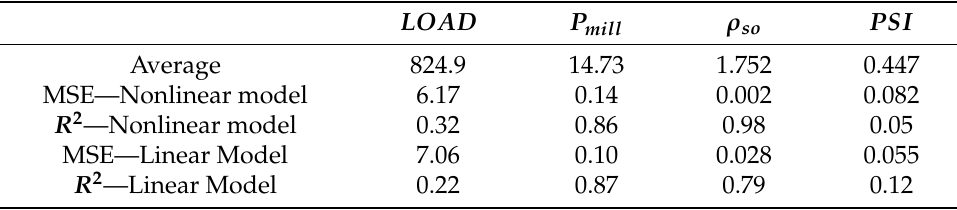
Table 4. Goodness-of-Fit